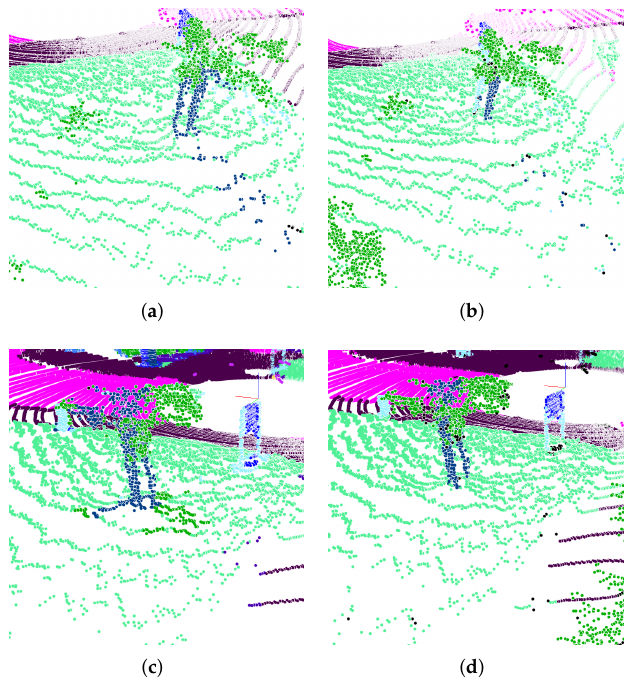
Figure 5. Projection error for different cases. The top row shows the spherical projection error for different images sizes. As the input features are not relevant for this type of error, the value for c in is irrelevant. The bottom row shows the bird’s-eye projection error for using a single image plane and using multiple ones. It is important to note that the projection error highly depends on the used projection size. ( a ) c in × 64 × 512; ( b ) c in × 64 × 2048; ( c ) Single plane; ( d ) Multi plane.